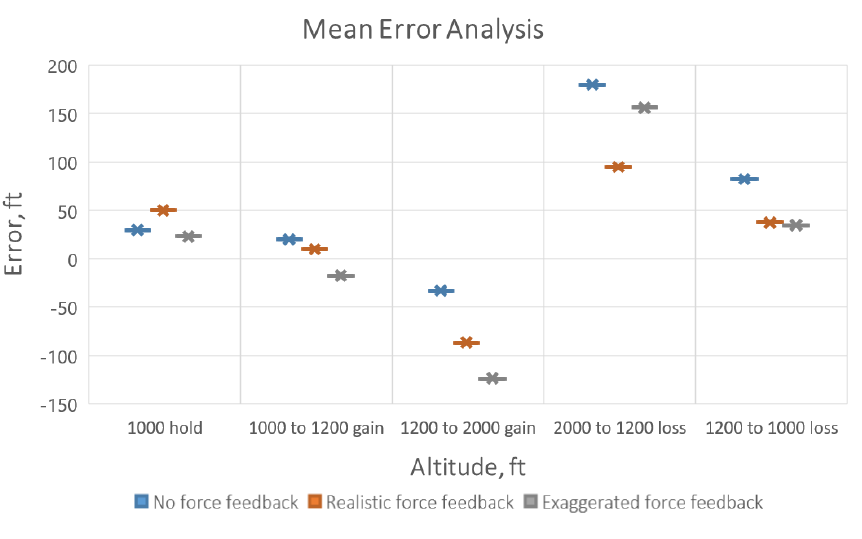
Figure 14. Mean error analysis at increasing and decreasing